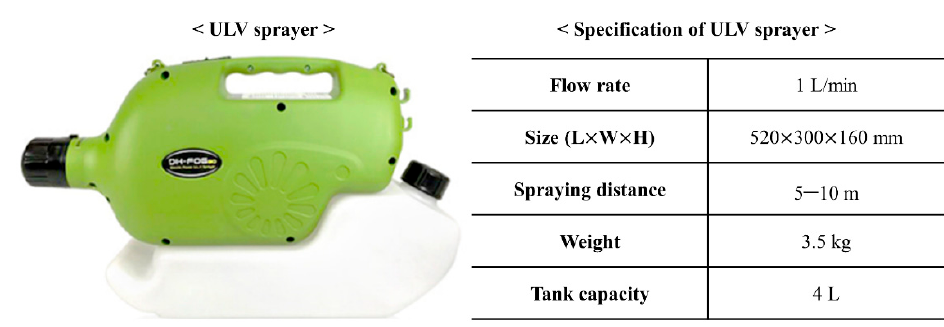
Figure 1. The ULV sprayer DH-FOG30 ′ s picture and